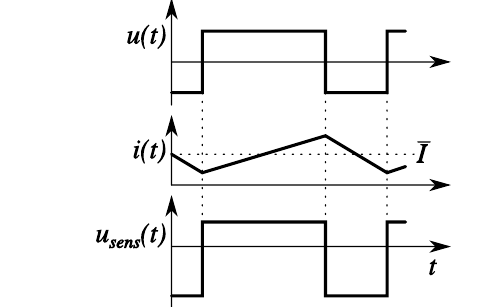
Figure 7. Actuator current and sensor coil voltage due to PWM control.